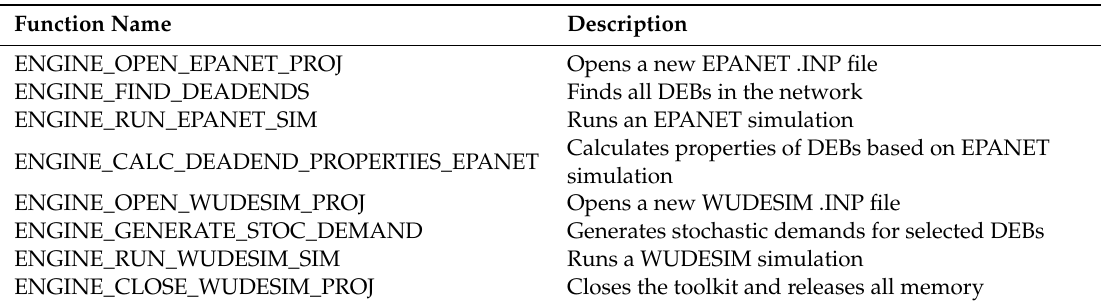
Table 2. Description of Engine Functions .